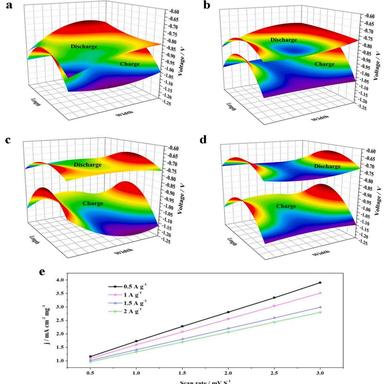
(a-d) and (e) the potential distribution and electrochemical active area of the coated carbon when cycling at 0.5 A g− 1 , 1 A g− 1 , 1.5A g− 1 and 2 A g− 1 .